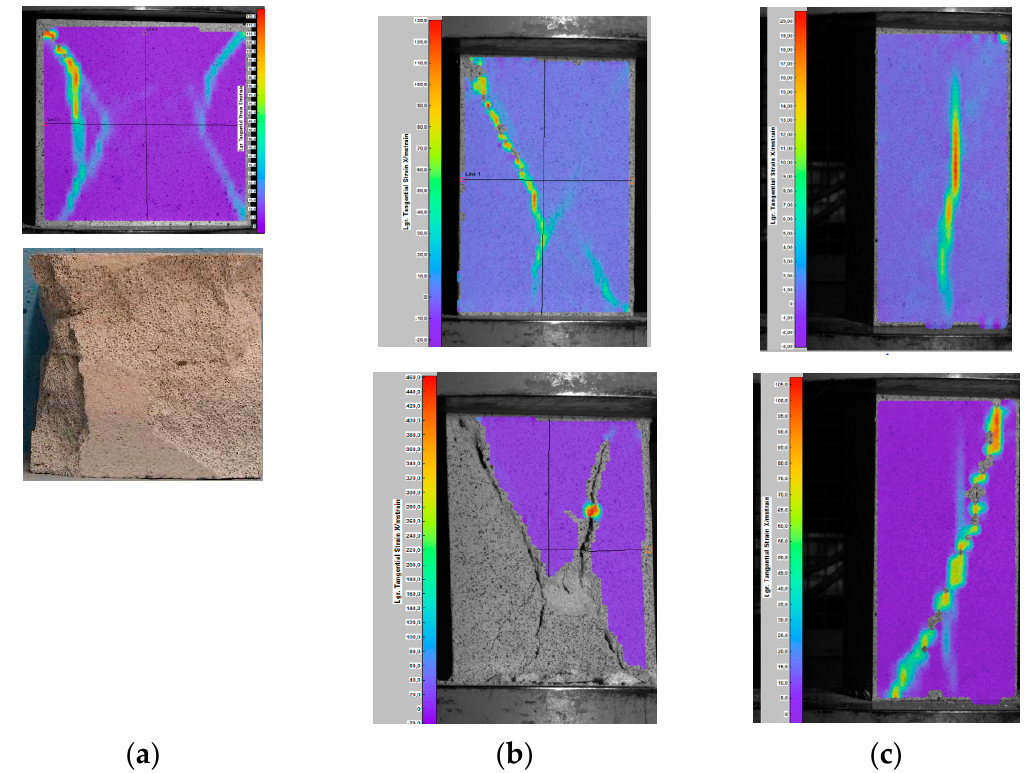
Figure 3 . Destruction of specimens with varying slenderness ratio [27]: ( a ) specimen 143 mm × 143 mm × 143 mm, ( b ) specimen 100 mm × 100 mm × 200 mm, and ( c ) specimen 80 mm × 80 mm × 158 mm.